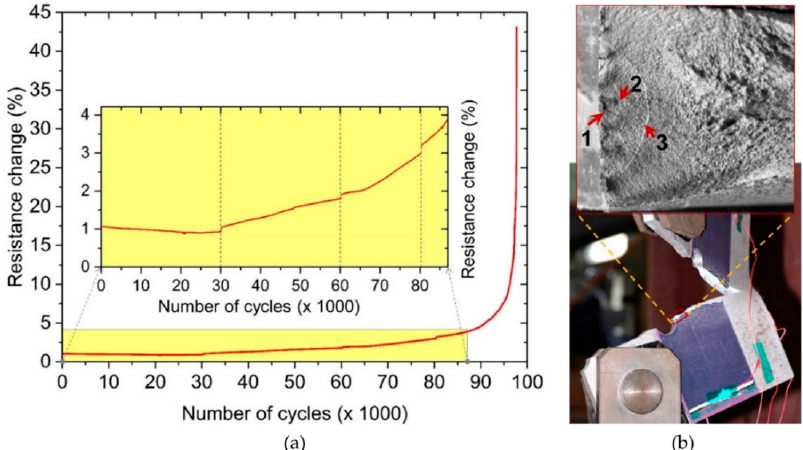
Figure 11. Crack re-initiation from a crack-stop hole: ( a ) resistance change (%) vs. number of applied load cycles. Dashed lines in inset show the number of load cycles corresponding to beach marks; ( b ) failure of the specimen with crack-stop hole beach marks (inset) marked by arrows numbered 1 to 3.